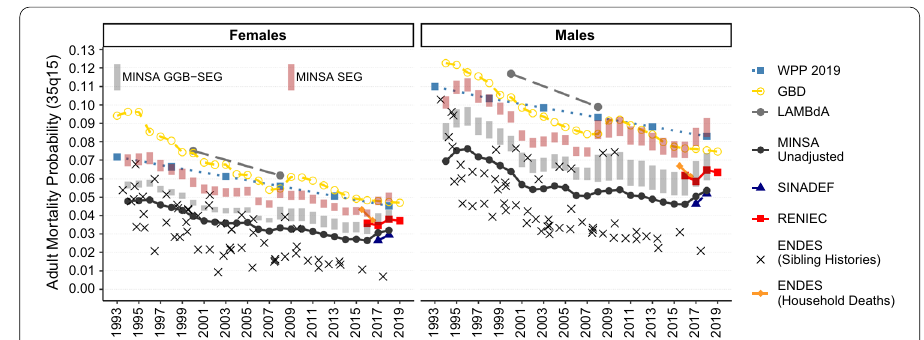
Fig. 1 Adult mortality probability— 35 q 15 —estimates computed from MINSA, SINADEF, RENIEC, ENDES, WPP 2019, and GBD 2019 data by year and sex from 1990 to 2019, Peru. MINSA results were adjusted by GGB–SEG and SEG sensitivity analysis